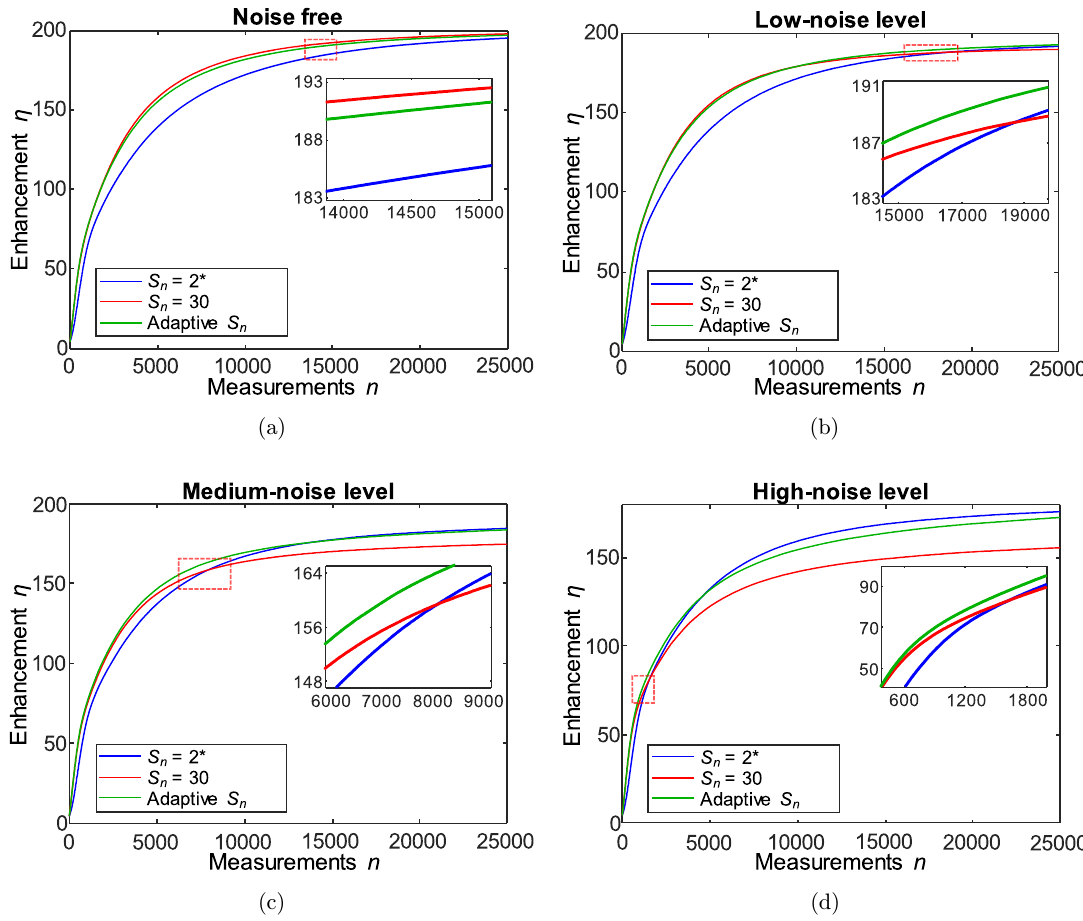
Fig. 4. Comparisons of di®erent schemes to select parents. S n = 2 is the one used in Ref. 18, which is marked with an asterisk. (a) – (d) The enhancement as a function of the number of measurements under di®erent conditions: noise free, low-noise level, medium-noise level, and high-noise level. Insets are provided for visualization